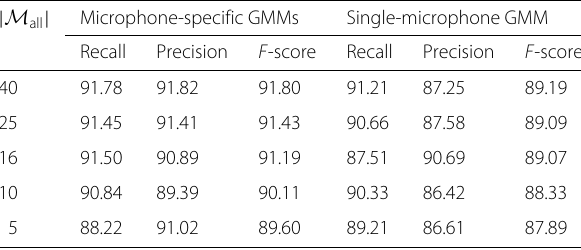
Table 7 Room-independent SAD results on the DIRHA-sim test set, employing all available microphones ( | M all |= 40) or the reduced setups of Fig. 12